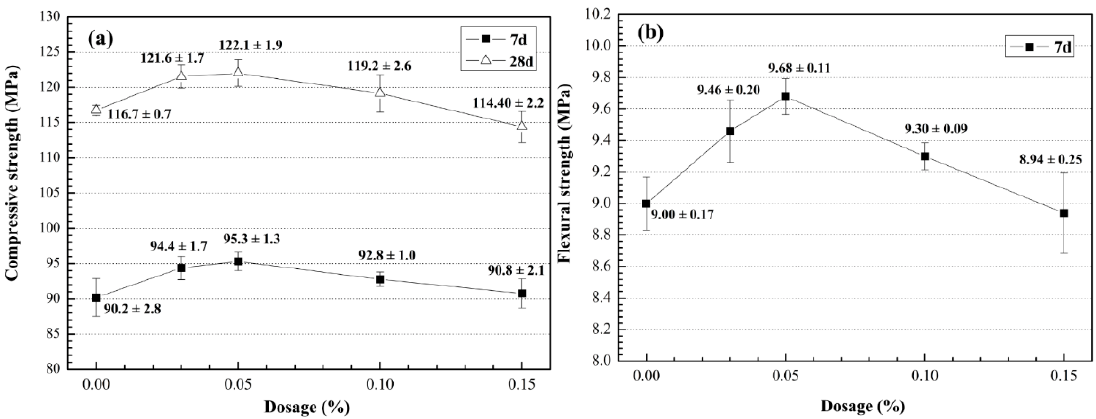
Figure 3. Mechanical properties of UHSC containing MWCNTs. ( a ) compressive strength; ( b ) flexural strength.